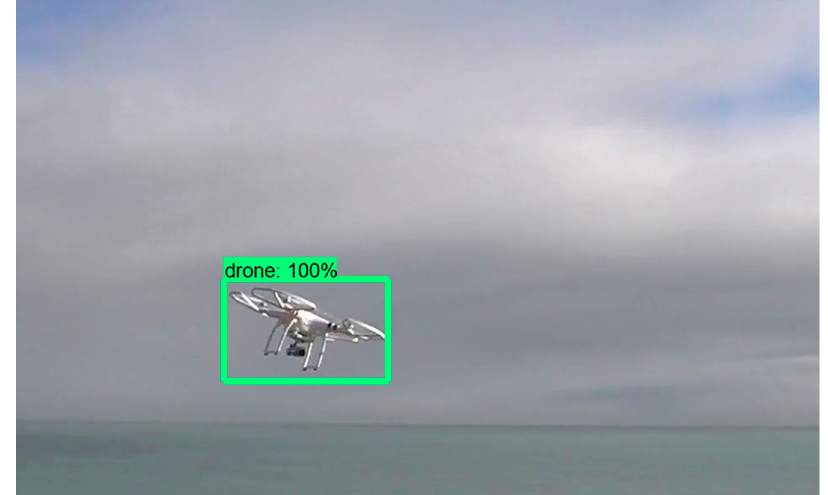
Figure 19. Detection of the drone in the sky.